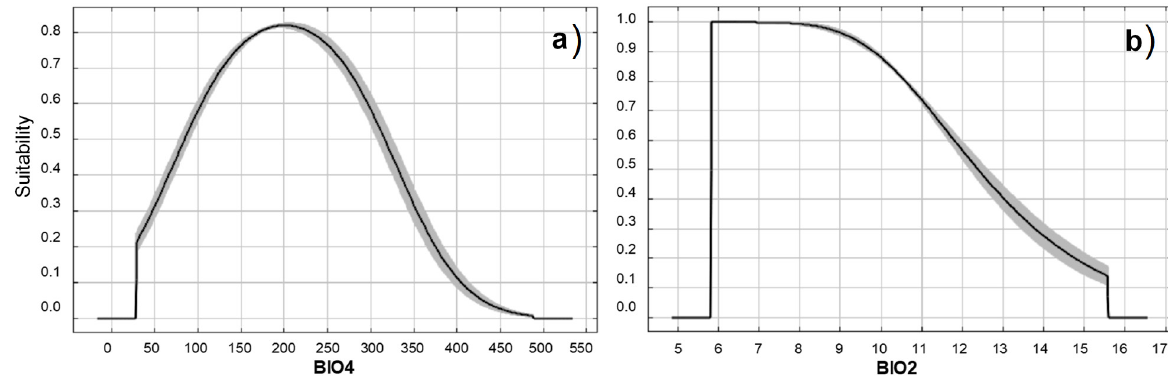
Figure 5. Response curves for the environmental variables with the highest contribution to the MaxEnt species distribution model for Melanoides tuberculata in Argentina: a) temperature seasonality (BIO4); b) mean diurnal range of temperature (BIO2). Values shown are averages (black line) and standard deviation (gray bands) calculated over 10 replicate runs. (BIO4 is temperature [°C] standard deviation × 100 and BIO2 is temperature